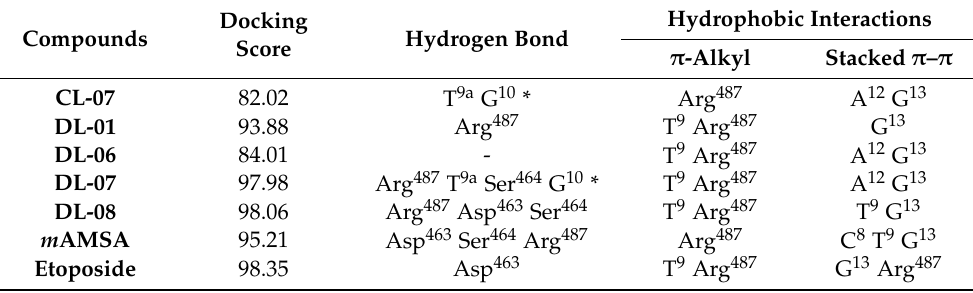
Figure 3. Final pose of molecular docking for some drugs and DL-01 with DNA–Topo II α . On the left, final conformers of amsacrine (yellow) and etoposide (purple) complexed with human DNA–Topo II α (PDB ID: 5gwk); on the right, a detailed illustration of the intermolecular interactions of DL-01 (green) compared to amsacrine. The dashes indicate the polar interactions made by each structure with the receptor and follow their respective colors. Table 3. Docking scores and interacting residues of test compounds with DNA–Topo II α .